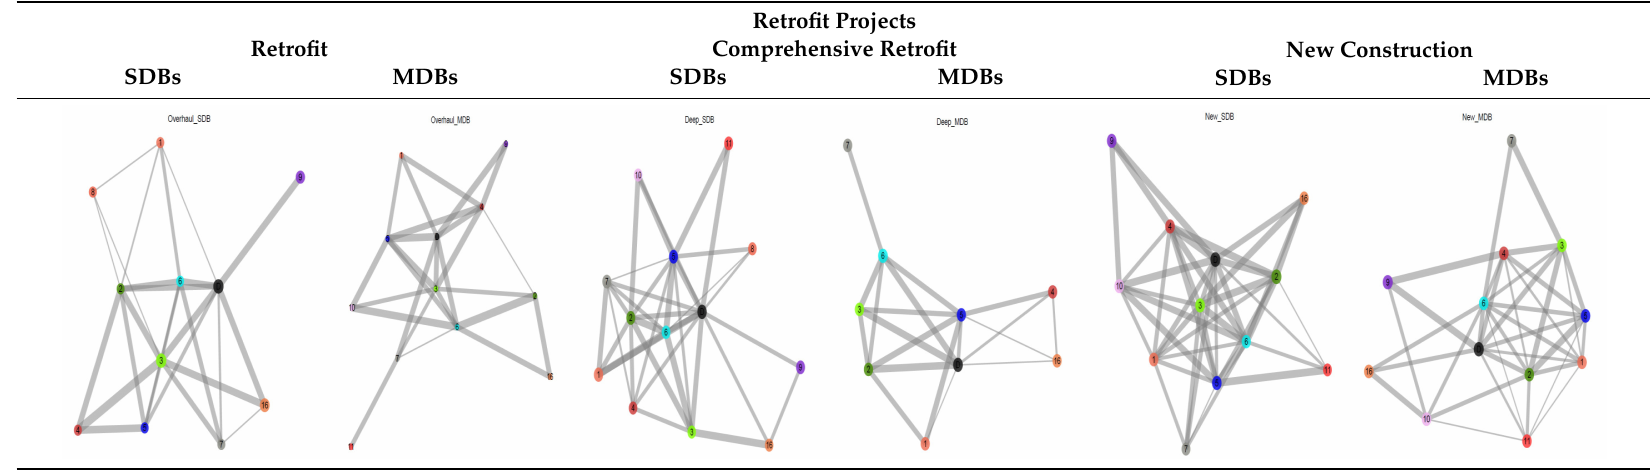
Table 4. Stakeholder level of power and interaction in the technology selection, classified according to building typologies and project types in Italy (IT).